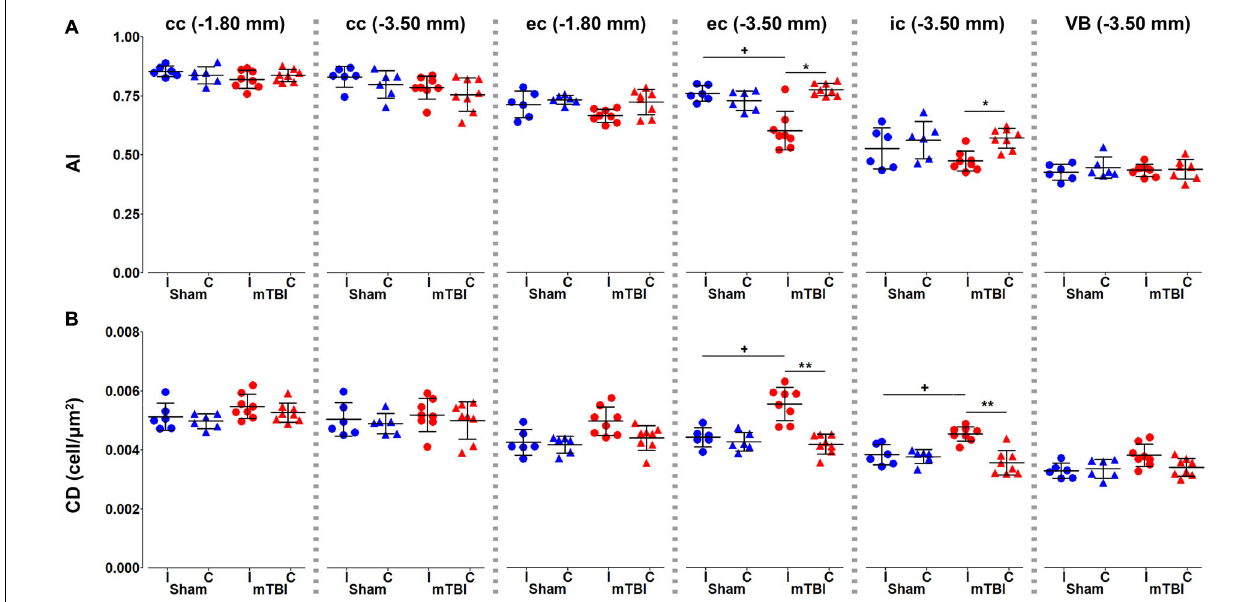
FIGURE 7 | Histology metrics, anisotropy index (A) and cellular density (B) , were analyzed in the corpus callosum and external capsule at –1.80 and –3.50 mm, and the internal capsule and ventrobasal complex at –3.50 mm from bregma. Sham-operated animals are indicated in blue and mTBI in red, while ipsi- and contralateral hemispheres are represented by circles and triangles, respectively. Results are shown as mean and standard deviation, and paired (*) t -test comparing ipsi- and contralateral sides within animals (* q < 0.05, ** q < 0.01) or unpaired (+) t -test comparing the same hemisphere between sham-operated and mTBI rats ( + q < 0.05), both FDR-corrected. AI, anisotropy index; cc, corpus callosum; CD, cellular density; ec, external capsule; ic, internal capsule; VB, ventrobasal